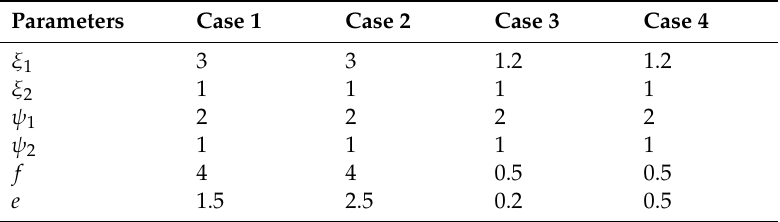
Table 8. The assumed values of the parameters under the four cases.